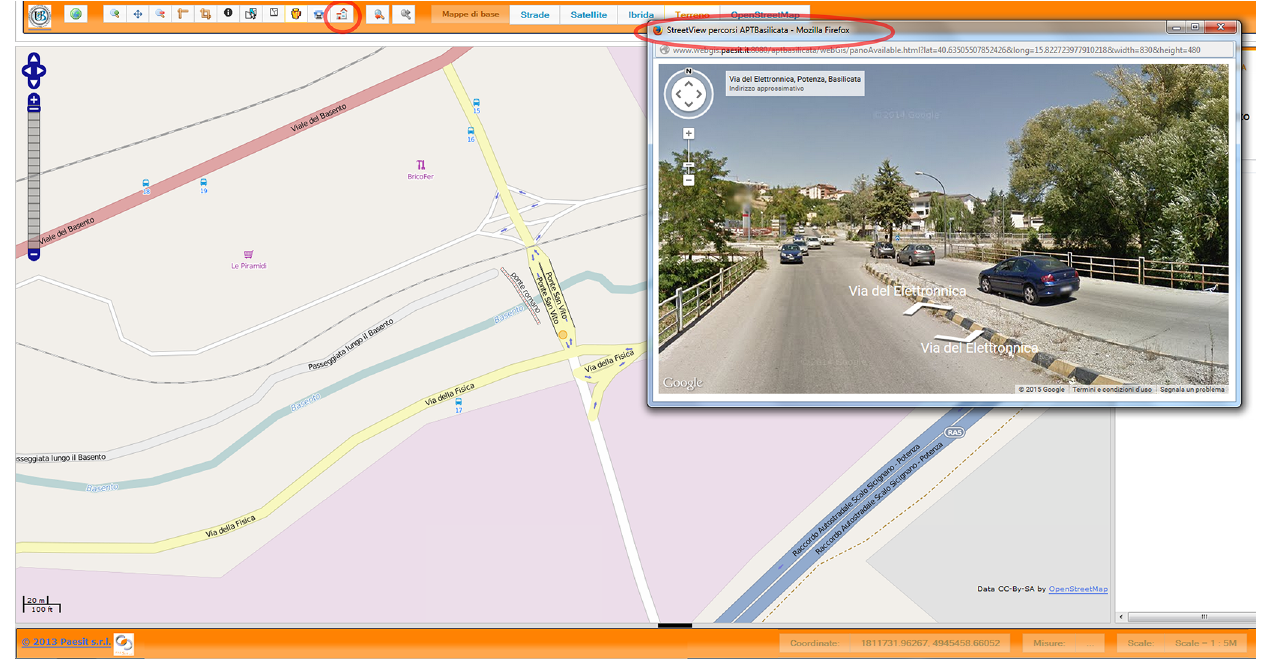
Figure 8. Visualization of the “San Vito” bridge by the Google Street tool.